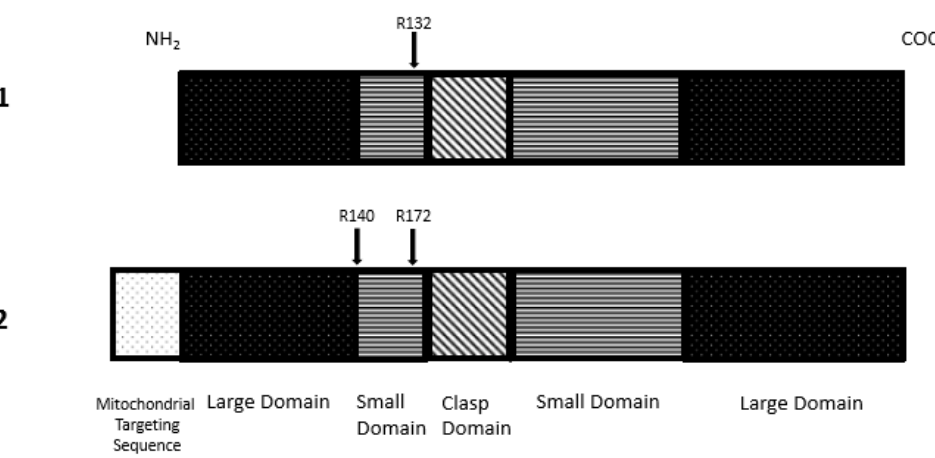
Figure 1. Domain map structure of isocitrate dehydrogenase (IDH) enzymes. IDH1 and IDH2 are